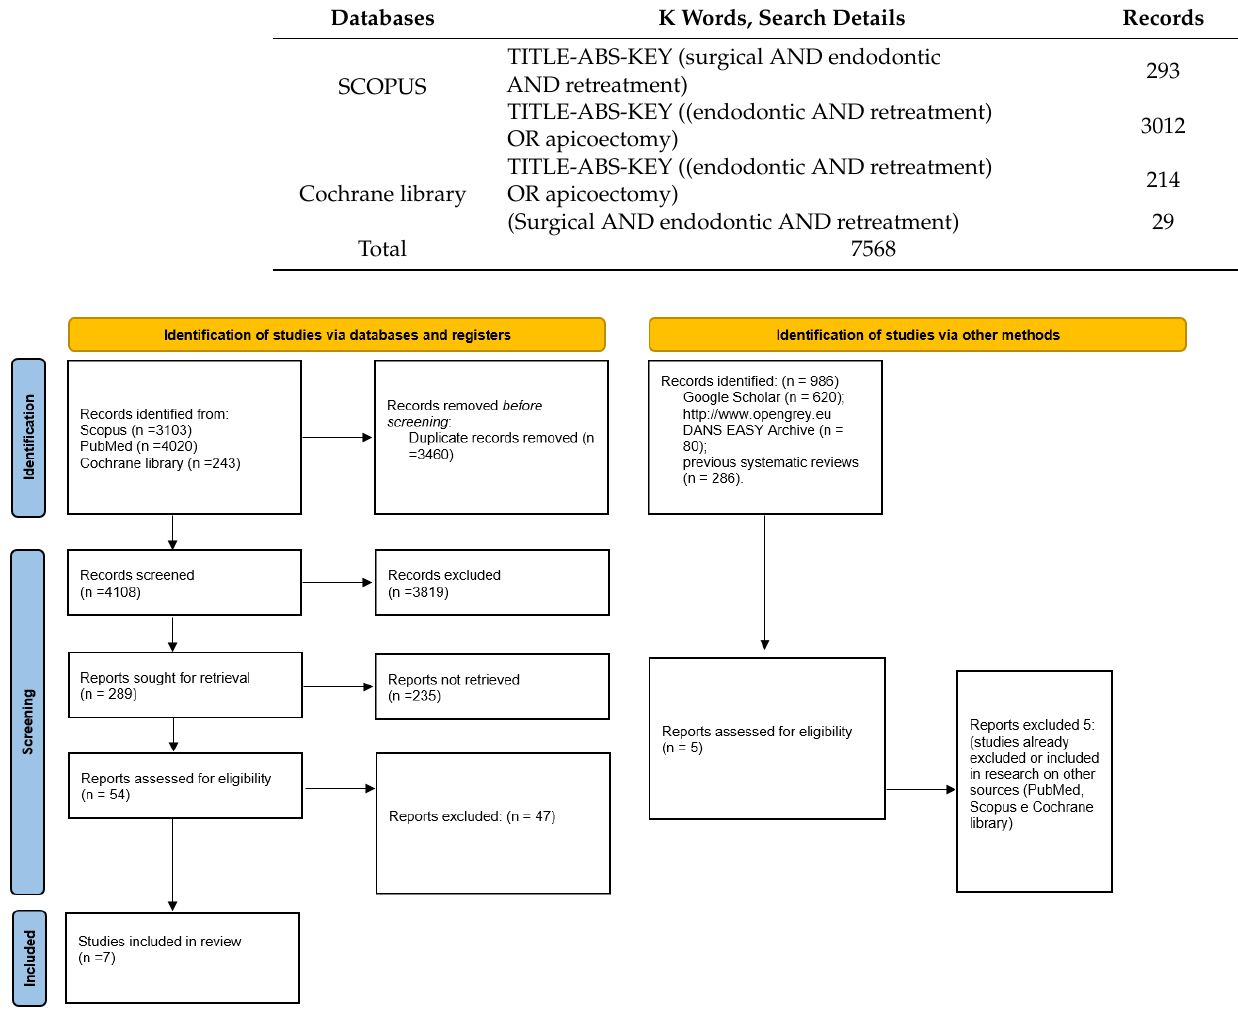
Figure 1. Entire selection and screening procedures as described in the PRISMA flowchart.